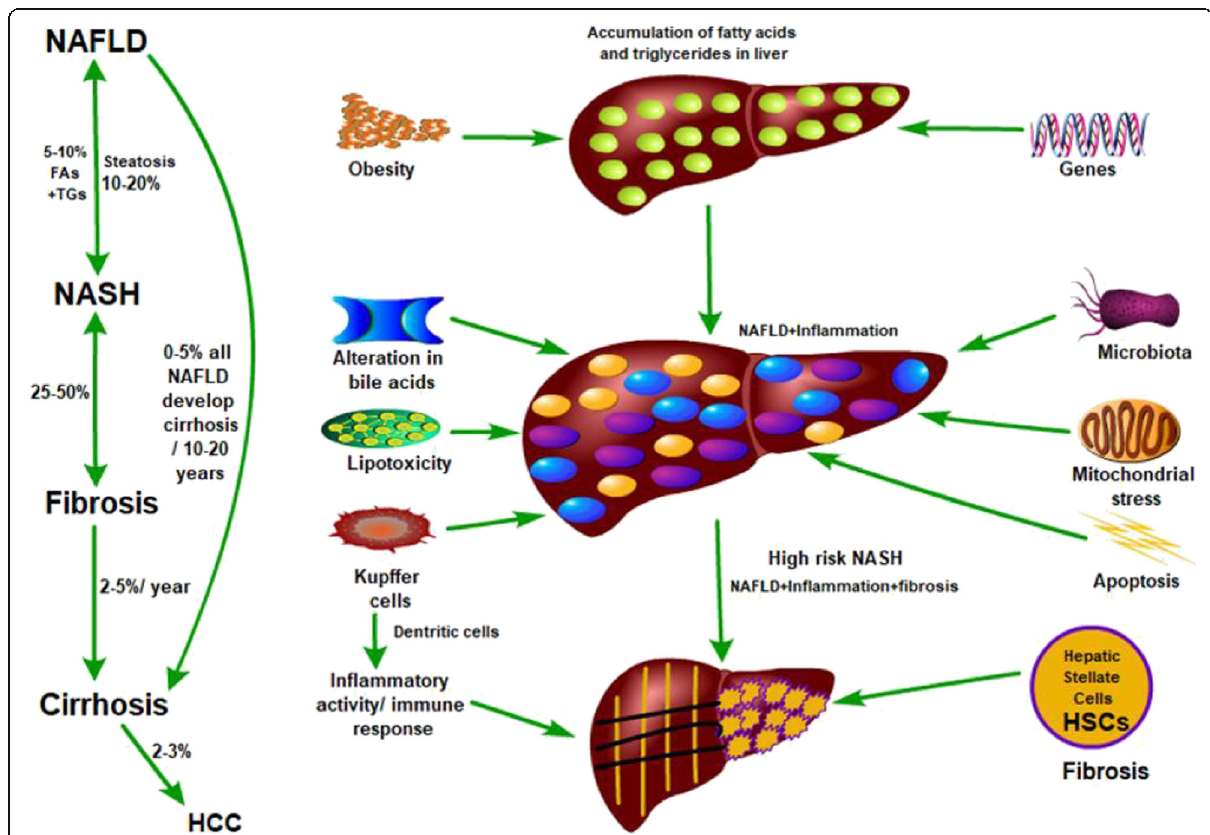
Fig. 1 Spectrum of non-alcoholic fatty liver disease (NAFLD) and its progression to hepatocellular carcinoma